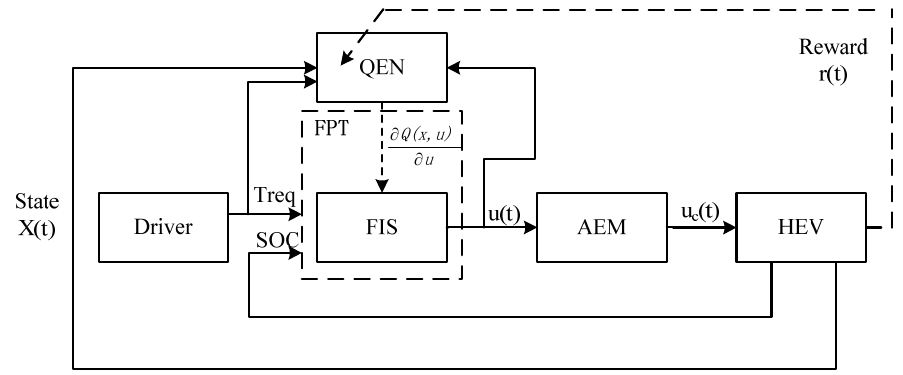
Figure 2. The schematic diagram of fuzzy Q-learning (FQL) control strategy. QEN: Q *( x , u